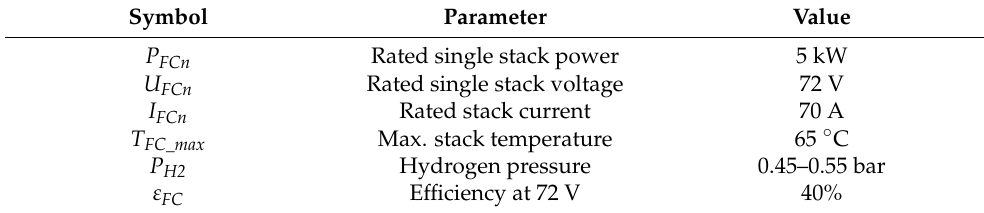
Table 1. Parameters of the single fuel cell